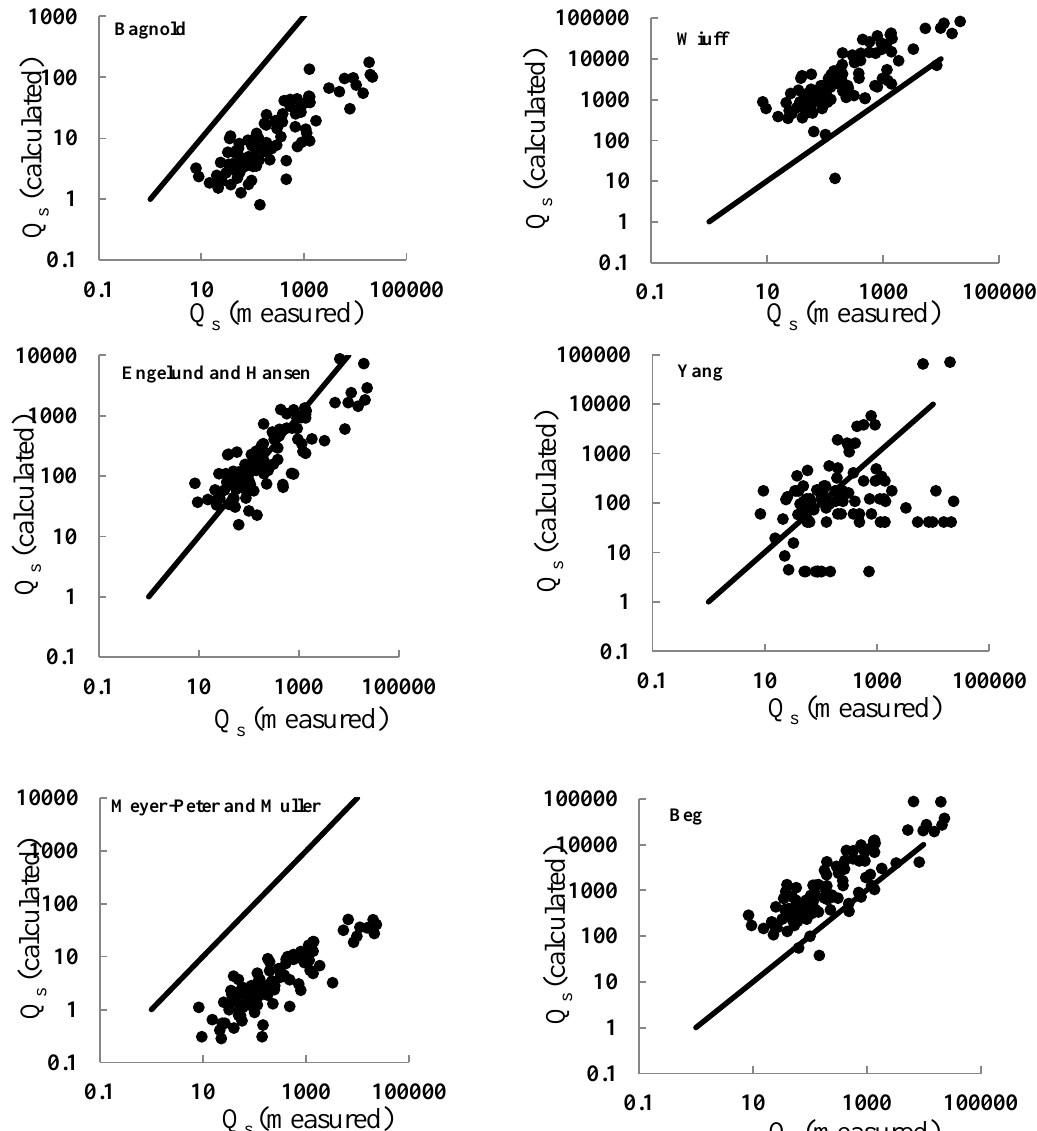
Fig. 2. Comparison between measured and calculated sediment load concentration of The Karun River From the results of Table 3 and also Fig. 2 it can be concluded that Wiuff equation predicts the suspended sediment load of the Karun River higher than the measured values with RMSE of 54435 ton/day and R 2 of 0.35. While Bagnold and Toffaleti equations predict suspended sediment load less than measured values with RMSE of 4167 and 2504 ton/day and R 2 of 0.61 and 0.68 respectively. The predicted values of sediment load by Einstein, Samaga and Van Rijn equations are unclear and imprecise (Fig. 2 a, c, e,